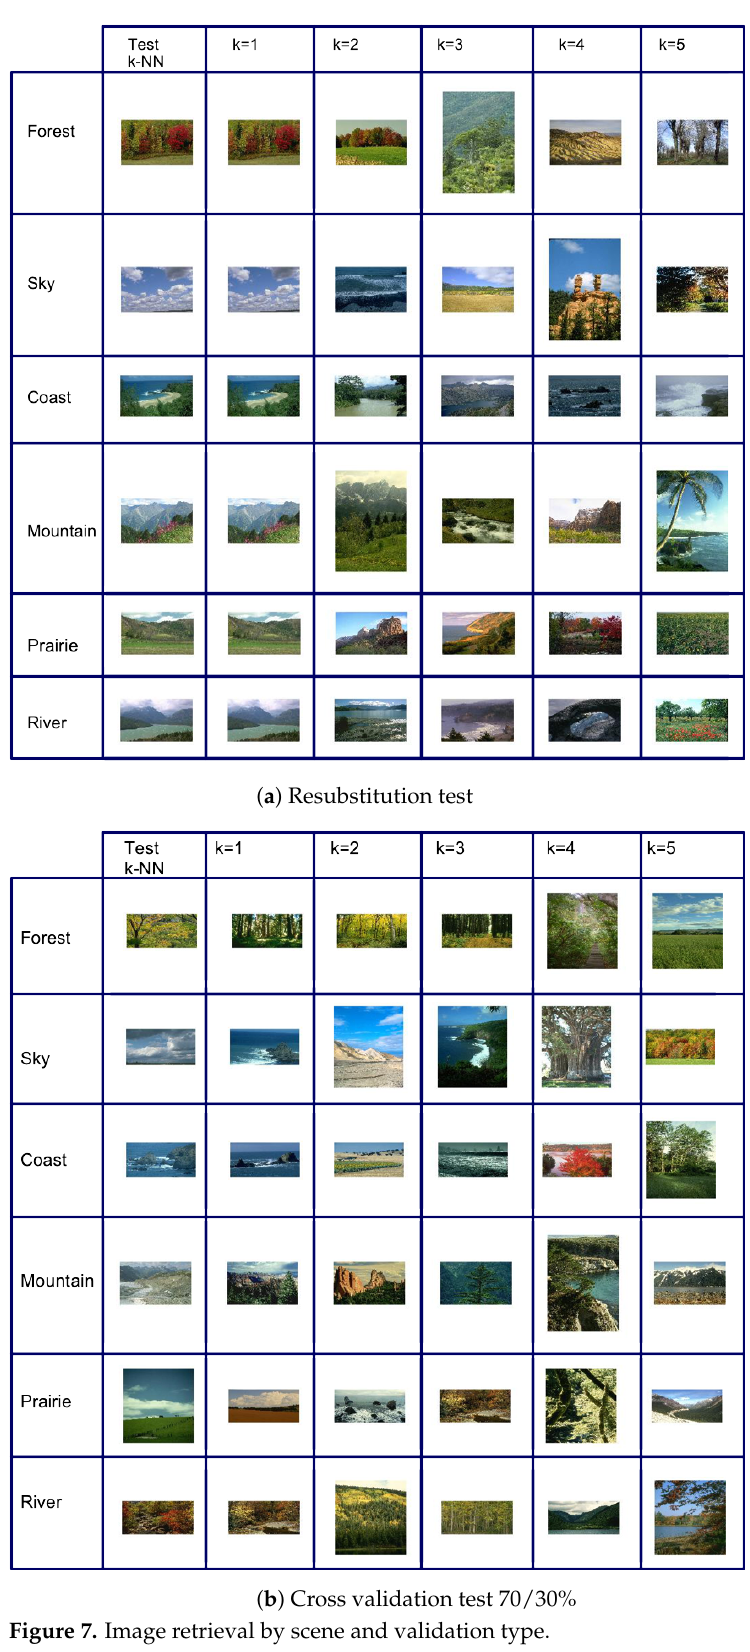
Figure 7. Image retrieval by scene and validation